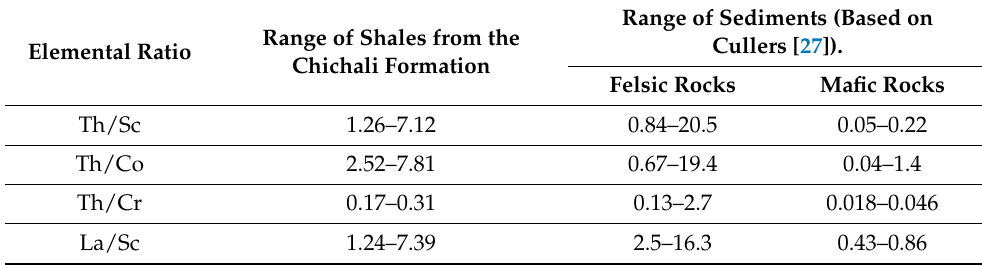
Table 2. The elemental ratios of shales from the Chichali Formation were compared to those of equivalent fractions obtained from felsic and mafic rocks in this research. Range of Sediments (Based on Range of Shales from the Cullers Elemental Ratio Chichali Formation